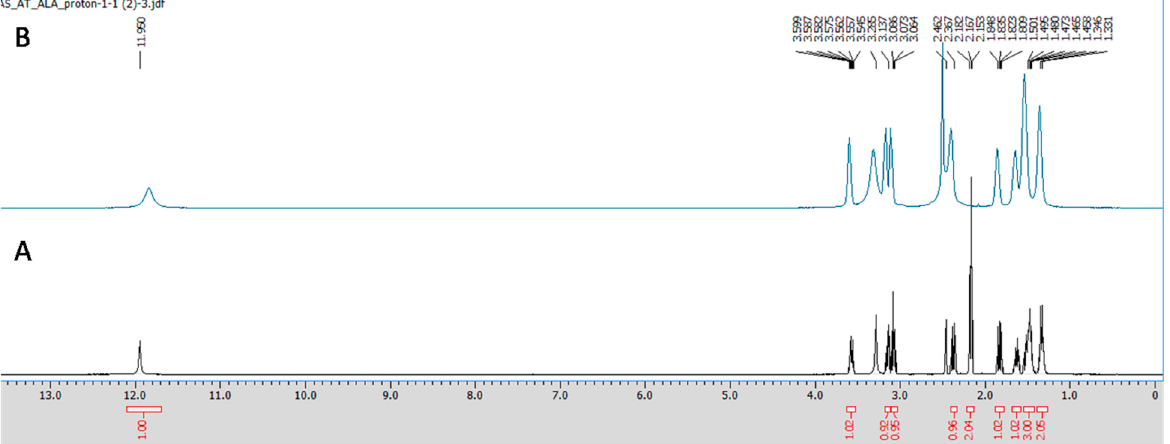
Figure 4. 1 H NMR of ( A ) ALA and( B ) ALA with Cu after 5 min in DMSO- d 6 at 500 MHz. A singlet peak at 11.95 was attributed to the -COOH group, and after the addition of Cu, the peak was upward shifted to 11.83 ppm.